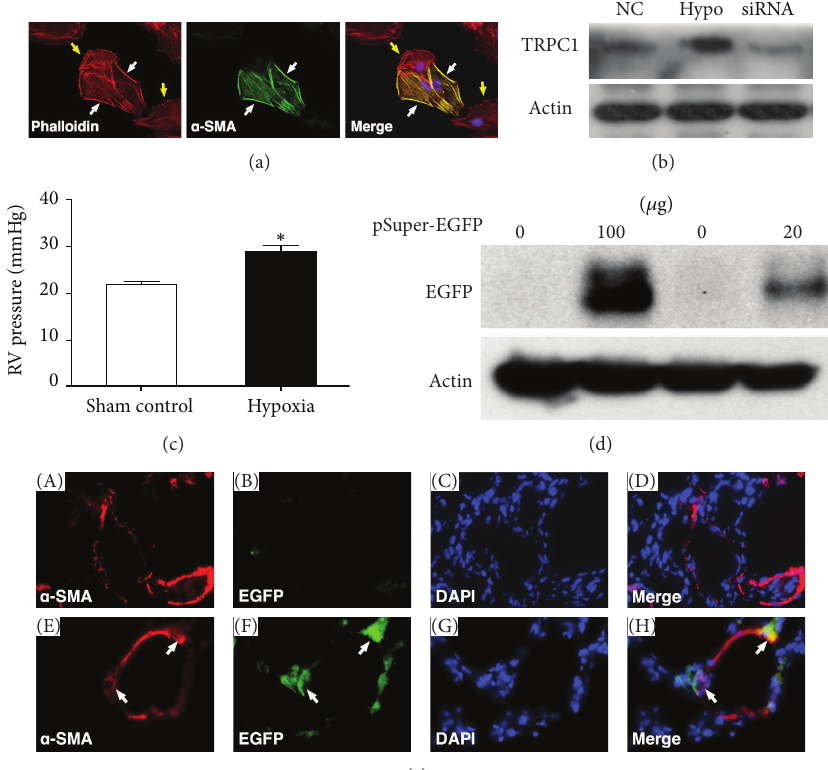
Figure 1: In vitro and in vivo pilot studies validating the murine model of pulmonary arterial hypertension (PAH). (a) Immunofluorescent studies demonstrating successful primary cell culture using the aortic smooth muscle cells (SMCs) from murine aorta, showing SMCs (white arrows) and non-SMCs. (b) Western blot analysis ( 𝑛 = 3 ) of primary SMC culture showing markedly suppressed transient receptor potential cation channel (TRPC) 1 protein expression in SMCs after siRNA-knockdown (20 nM), suggesting successful knockdown of TRPC1 expression with Lipofectamine delivered siRNA. (c) Significantly elevated right ventricular systolic pressure (RVSP) in animals by 14 days after hypoxia treatment compared to that in normal controls, indicating successful establishment of the murine model of pulmonary arterial hypertension. ∗ versus control, 𝑃 = 0.0054 ( 𝑛 = 4 for each group). (d) Western blot and (e) IF analyses ( 𝑛 = 3 ) of lung tissues demonstrating successful pulmonary delivery of Lipofectamine delivered enhanced green fluorescence protein plasmid (pEGFP) through inhalation. (d) WesternblotanalysisshowingenhancedEGFPexpressionaspSuper-EGFPconcentrationincreased.(e)IFdemonstrating(B)controlplasmid without EGFP expression in lung tissue and (H) the merged image, indicating successful Lipofectamine transfection of EGFP plasmid into the pulmonary arteriolar (PA) SMCs (white arrows). Blue fluorescence indicates DAPI-stained nuclei. 𝛼 -SMA: alpha-smooth muscle actin